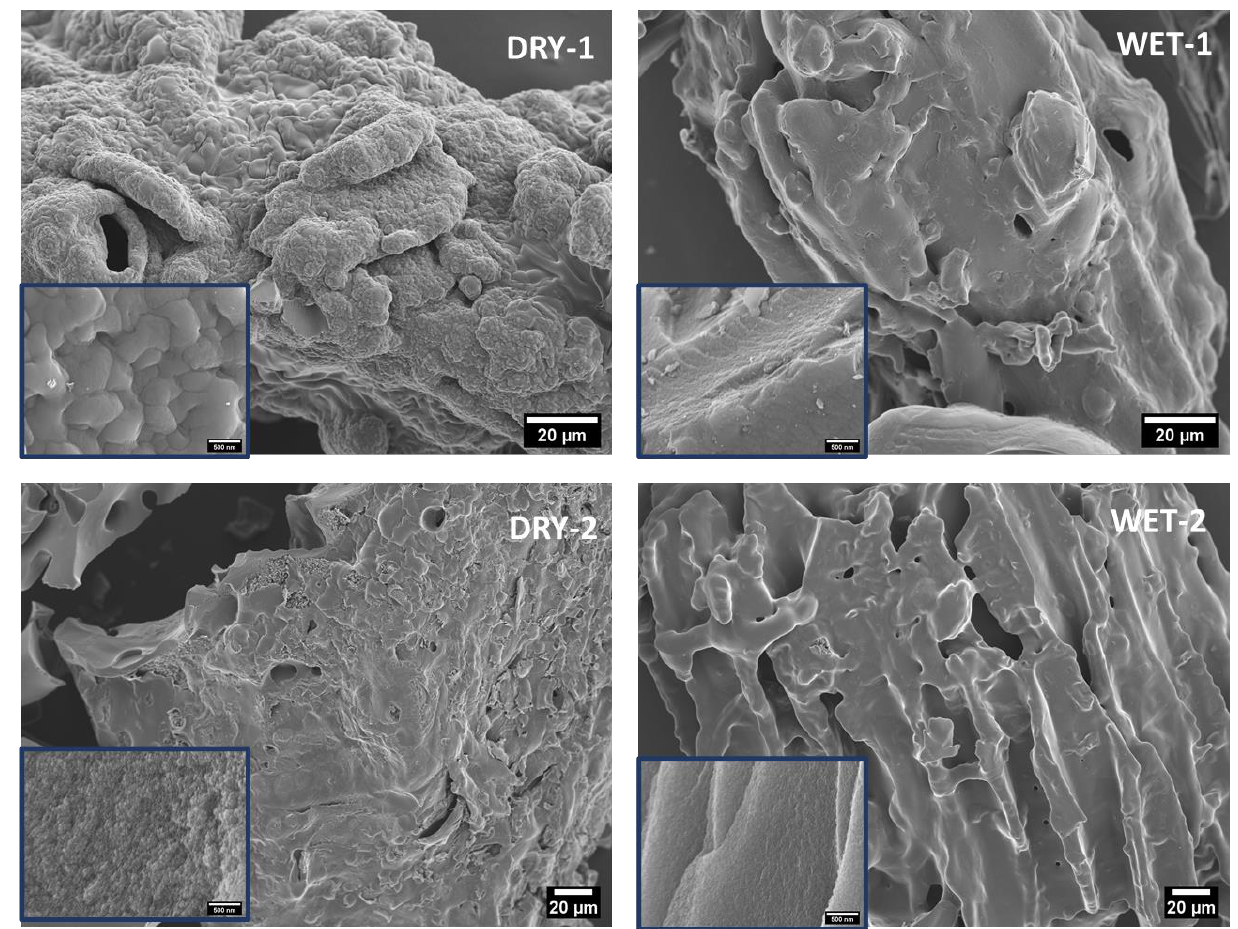
Figure 2. SEM images of the prepared samples with the inserts showing a magnified central area. (Scale bar for the inserts is 500